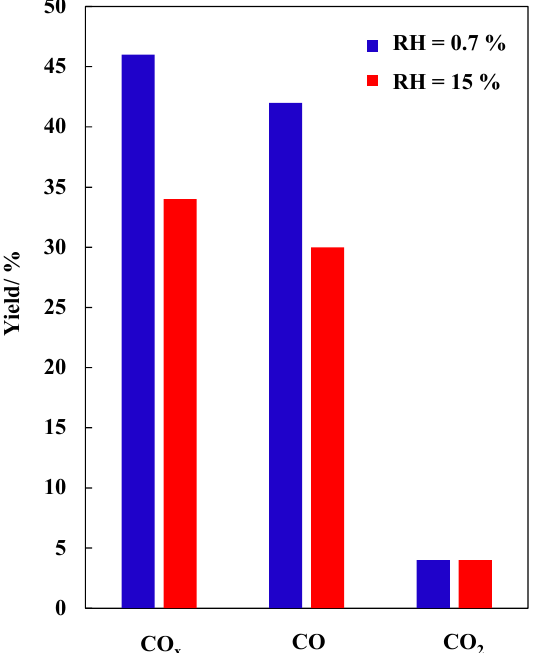
Figure 6. CO x , CO and CO 2 yields obtained in NTP TCE abatement with RH of 0.7% and 15% (ED = 150 J/L; Q = 1 L/min; [TCE] 0 = 150 ppmv). The FTIR spectra of the inlet TCE and outlet stream after NTP TCE abatement, with 0.7% and 15% as the relative humidity, are presented in Figure 7. The FTIR spectra for the inlet TCE showed the characteristic bands of TCE. The characteristics bands for TCE at 945 and 865 cm − 1 were still present but their relative intensities were higher in humid air, in accordance with the lowest TCE conversion discussed above. Furthermore, (oxi-)chlorinated by-products, such as dichloroacetchloride (DCAC; IR bands at 740, 989, 1076, 1055 (overlap with O 3 ) and 1773 cm − 1 ), phosgene (PG; IR bands at 852 (overlap with TCE) and 1827 cm − 1 ) and trichloroacetaldehyde (TCAD; IR band at 1760 cm − 1 ), were also detected in line with the incomplete gaseous oxidation of TCE. The detection and possible reaction schemes of formation of such (oxi-)chlorinated oxidation by-products have already been discussed elsewhere [46–48]. With almost no water in the feed (RH = 0.7%), TCE molecules